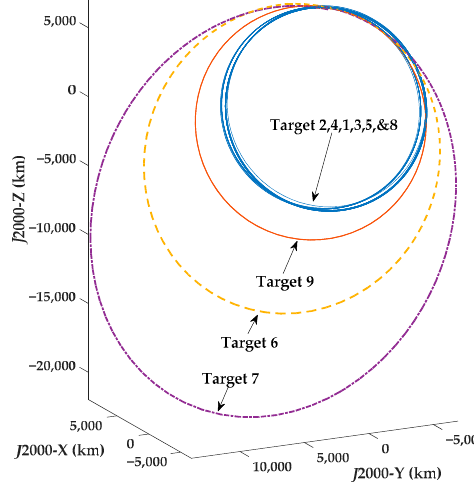
Figure 8. Optimal trajectory. Figure 8. Optimal